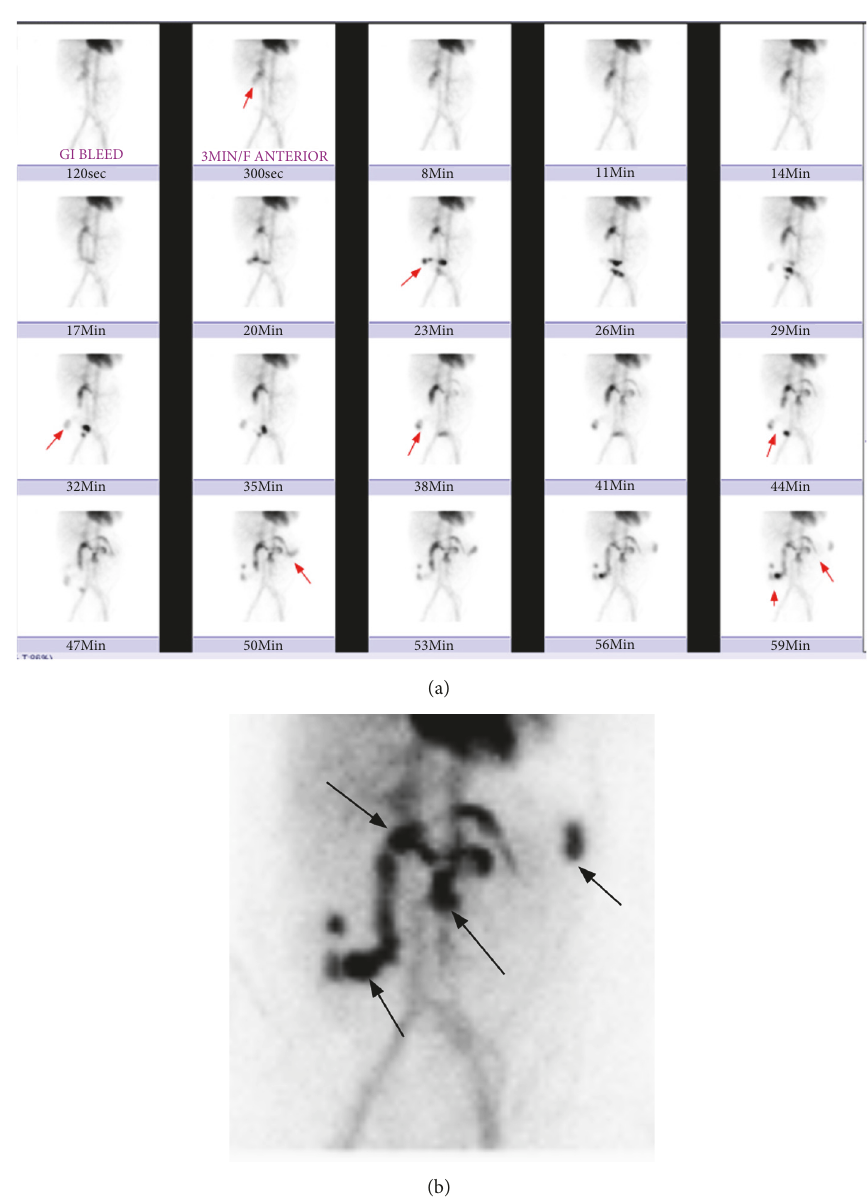
Figure 1: (a) Dynamic imaging sequence of a 99 Tc-labelled erythrocyte scan. The initial image (2min image) demonstrates normal biodistribution of the radiotracer. A focus of increasing intensity is noted in the right upper abdomen at the 3 min image (red arrow). This focus of abnormal accumulation of the radiotracer shows antegrade and retrograde movement, confirming the bowel lumen appearance, and it crosses the midline several times (on cine images). This pattern is compatible with small bowel bleeding. (b) This selected late image from the 99 Tc-labelled erythrocyte bleeding scan (59 min image) shows the typical pattern of small bowel bleeding (multiple red